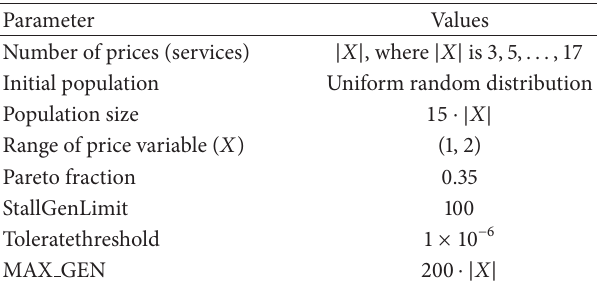
𝑄 𝑡 is the child population.